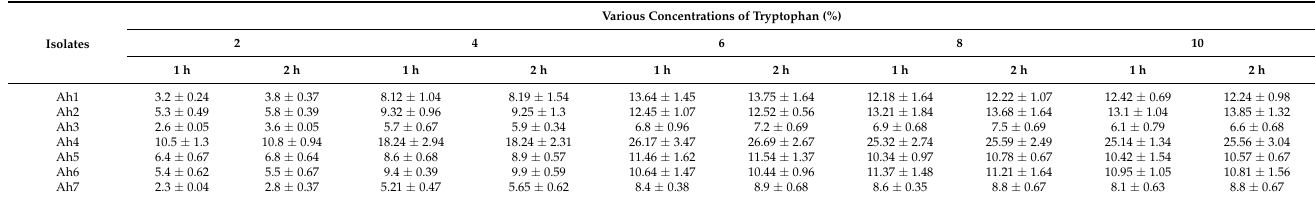
Table 2. IAA ( µ g · mL − 1 )-producing potential of test isolates on an hourly basis.